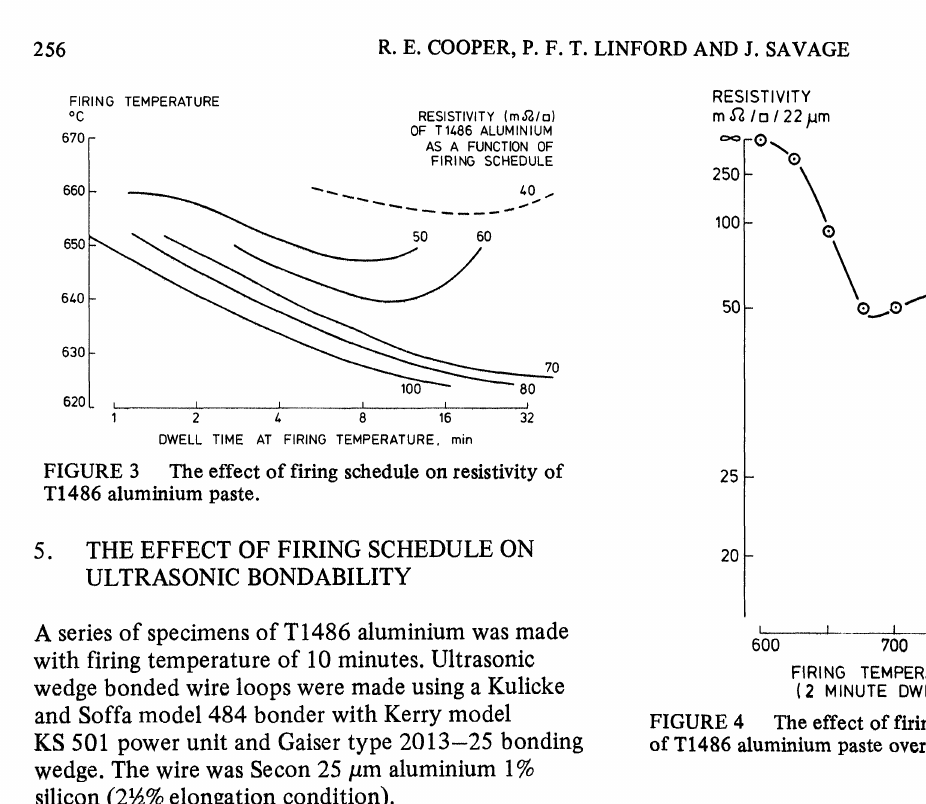
The effect of firing temperature on resistivity of T1486 aluminium paste over a wide temperature range. GOOD LOOPS PER 00